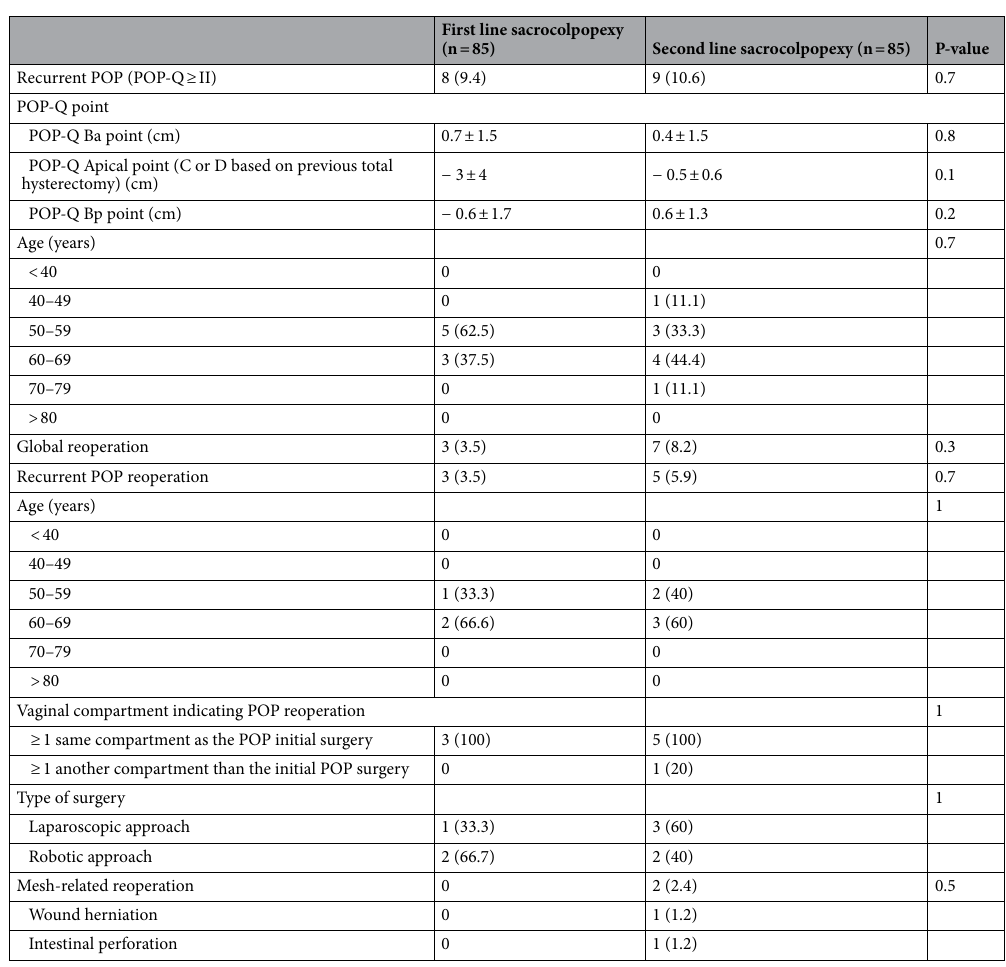
Table 2. Comparison of post-operative complications during follow-up between first line and second line sacrocolpopexies. Values are mean ± deviation standard or number of cases (percentage). n number of cases,